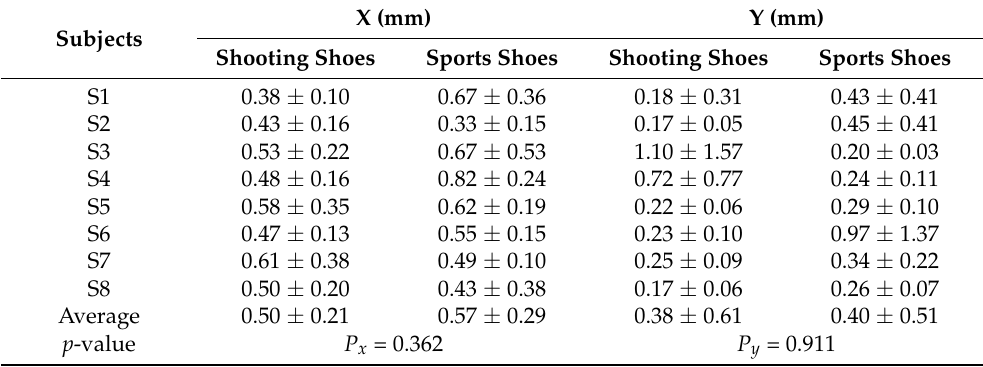
Table 4. Trajectory of center of pressure (COP) movement during use of shooting shoes and sports shoes (Mean ±